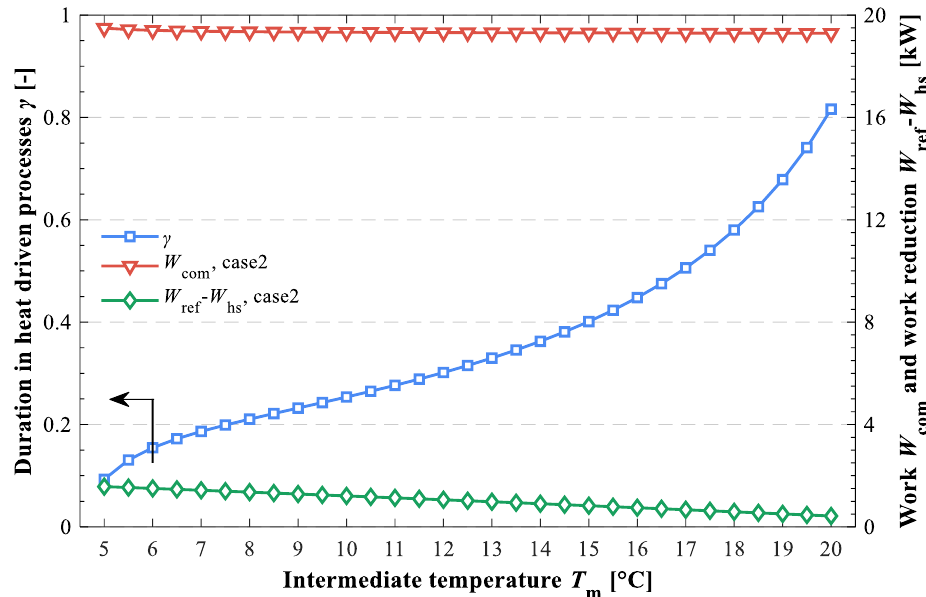
Figure 8. Effect of inter-stage pressure for the layout with a cascade condensation process in case 2.